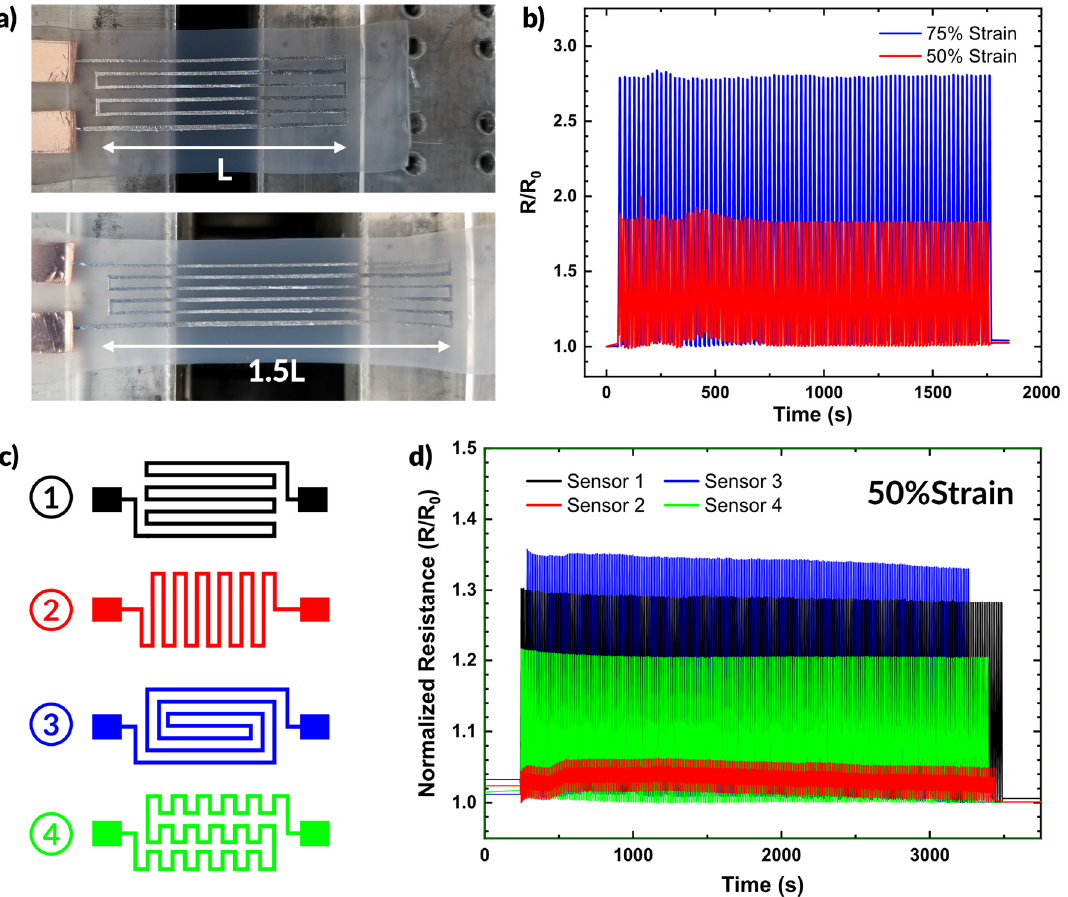
Figure 6. Applications of aerosol patterned devices. ( a ) Photographs of a sprayed liquid metal sensor being strained. ( b ) Plot of resistance over time during strain cycling at 50% and 75% strain. ( c , d ) A set of strain sensors with different geometries, and the impact the change in geometry has on the resistance during strain cycling plotted over time.